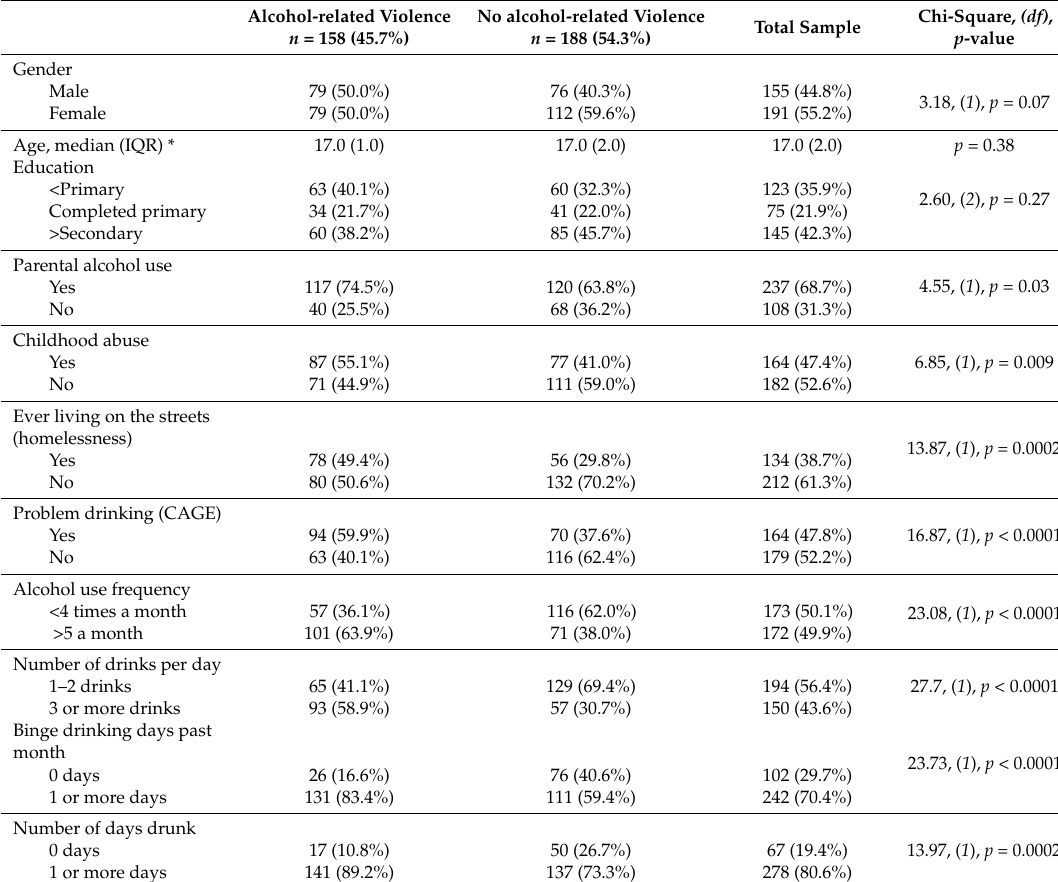
Table 1. Demographic characteristics and psychosocial correlates of alcohol-related violence among